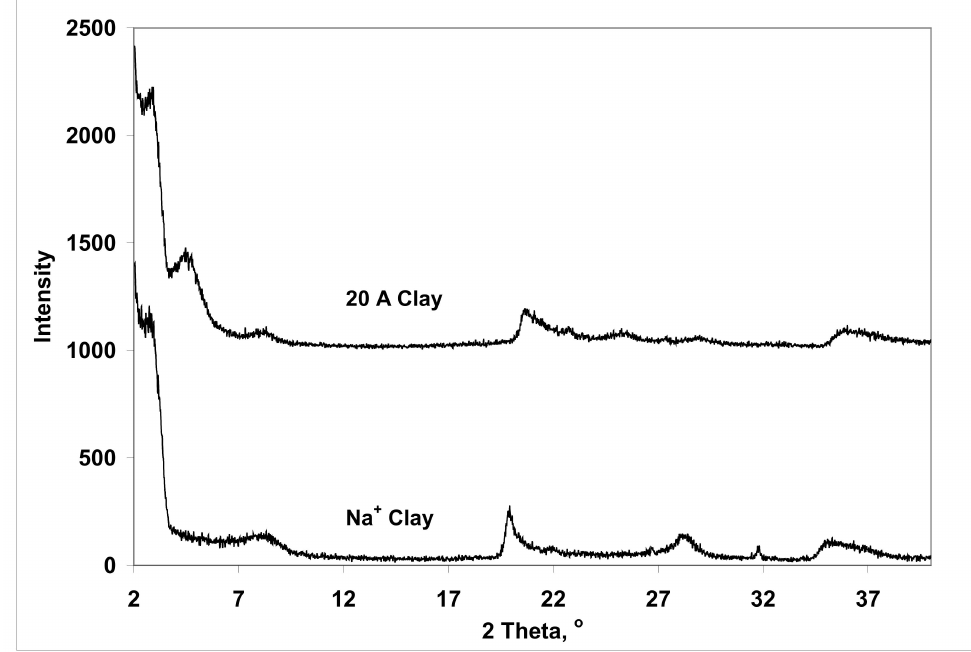
Figure 11. XRD patterns of CLOISITE ® 20 A clay and Na +